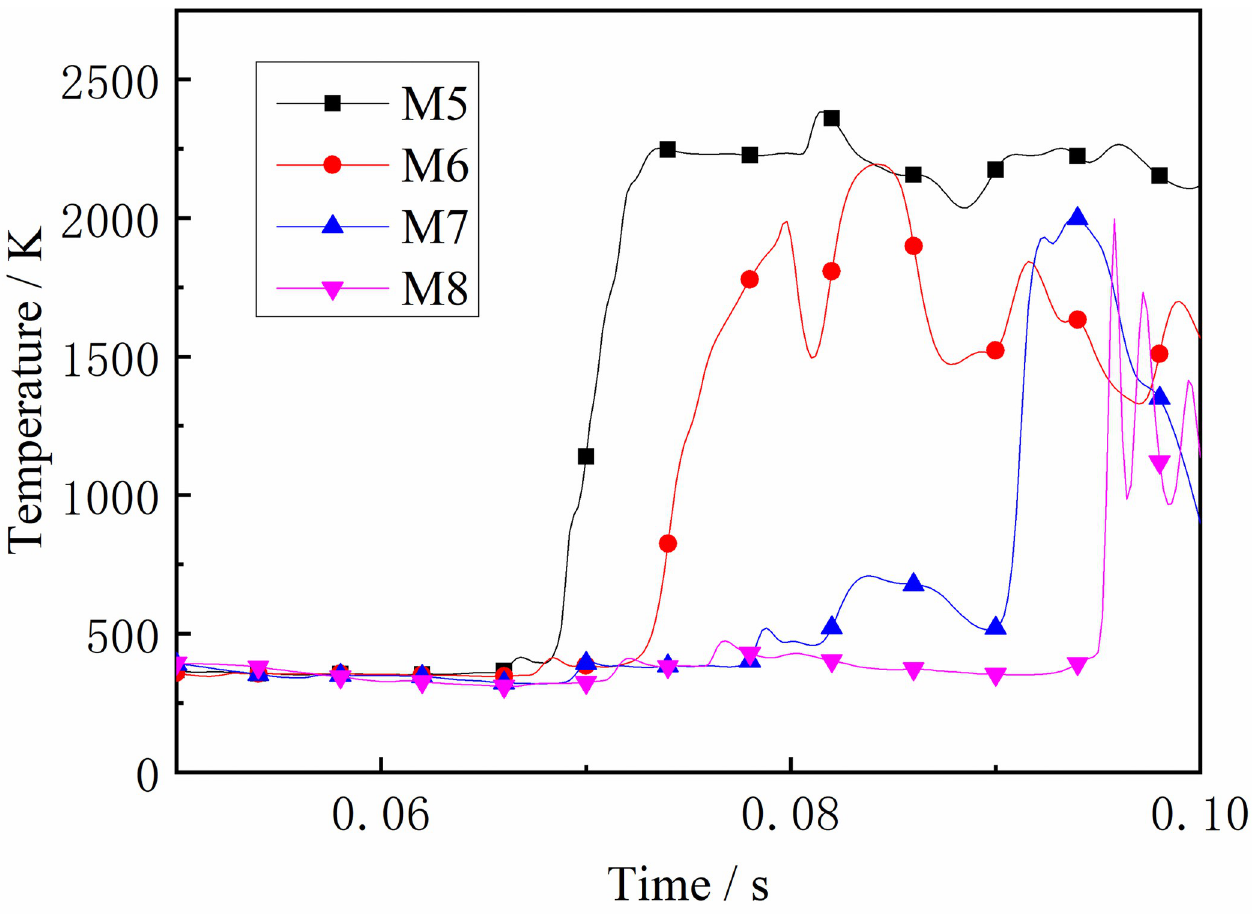
Fig 21. Temperature—Time curves at the monitoring point M5-M8 (gas concentration is 9.5%).